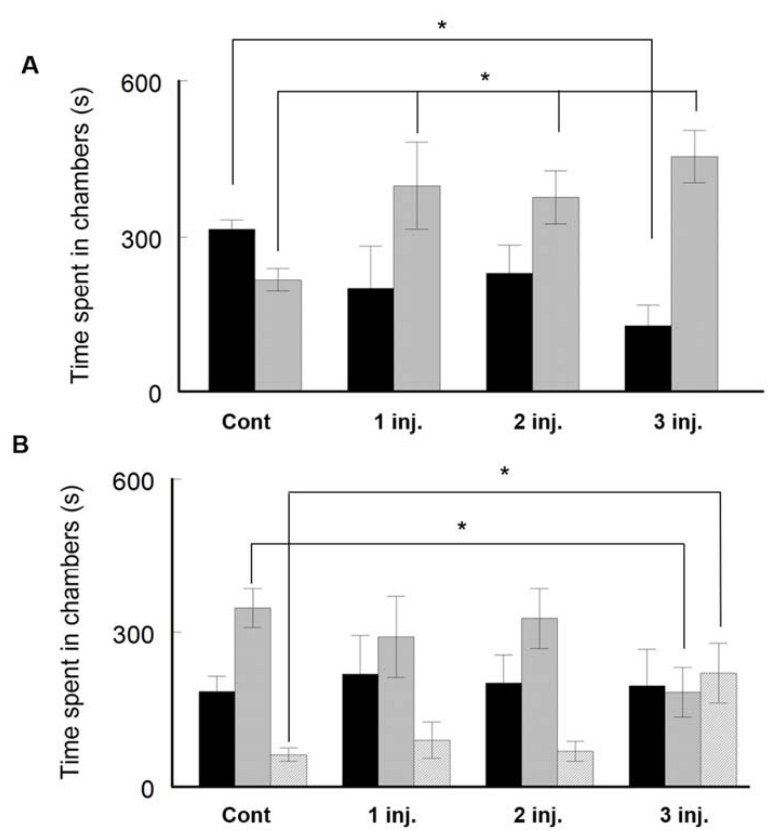
Figure 4. Assessment of social interaction on BALB/C mice by using the three-chambered social test. ( A ) Time spent in an empty chamber or the chamber containing a stranger animal. The black bar shows the time spent in a chamber containing a mouse while the grey bar represents the time spent in an empty chamber. ( B ) Time spent in an empty chamber or the chamber containing a previously explored animal or a newly stranger animal. The black bar represents the time spent in a chamber containing an already encountered mouse; the grey bar illustrates the time spent in a chamber containing a new mouse; while the hatched bar displays the time spent in an empty chamber. Data are expressed as mean ± SEM ( n = 3); * p < 0.05 when compared to control.